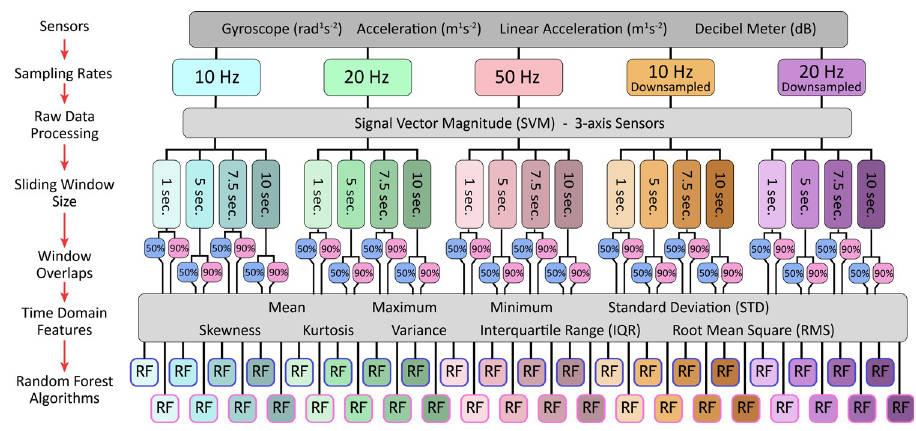
Fig 2. Activity recognition modelling data inputs and